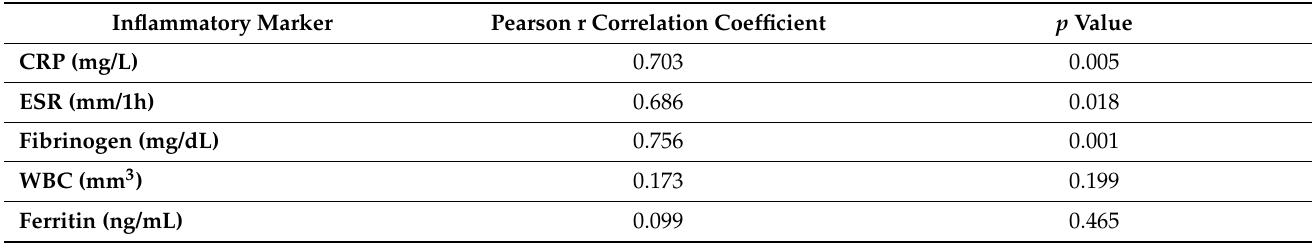
Table 5. Correlations between inflammatory markers and the presence of acute coronary atherothrombosis in COVID-19-positive patients.